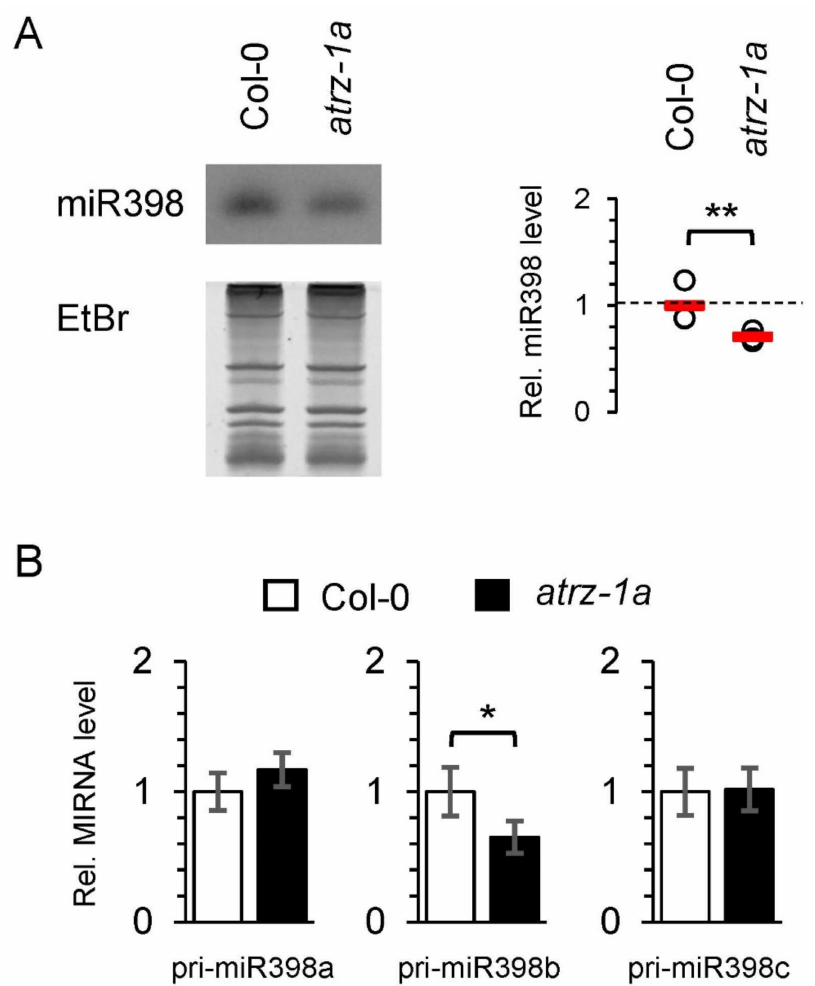
Figure 4. At RZ-1a affects the biogenesis of miR398. ( A ) MiR398 levels are reduced in atrz-1a mutants. An RNA gel blot of the atrz-1a mutant and the corresponding wild-type plants was hybridized with an anti-miR398 probe. Ethidium bromide (EtBr) staining serves as a loading control. MiR398 signals were quantified using ImageJ and fold changes of miR398 are expressed relative to wild-type. Shown are the mean ± SD of three biological replicates. ( B ) Pri-miR398b level is decreased in atrz-1a mutants. The levels of the pri-miR398a, b and c were analyzed in the atrz-1a mutant and wild-type by quantitative real-time PCR. Data are based on three biological replicates and shown as mean ± SD. A Student’s t -test was performed to determine statistical significance (** p ≤ 0.05, * p ≤